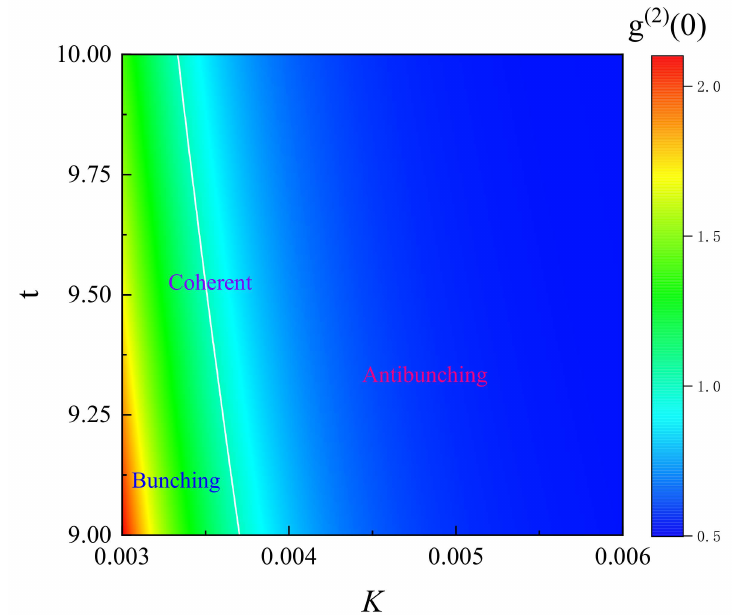
Figure 3. The second-order correlation function as a function of t and K , where K is dimensionless in units of ω , α a = 10, g = 10 K and α m = 0.5.